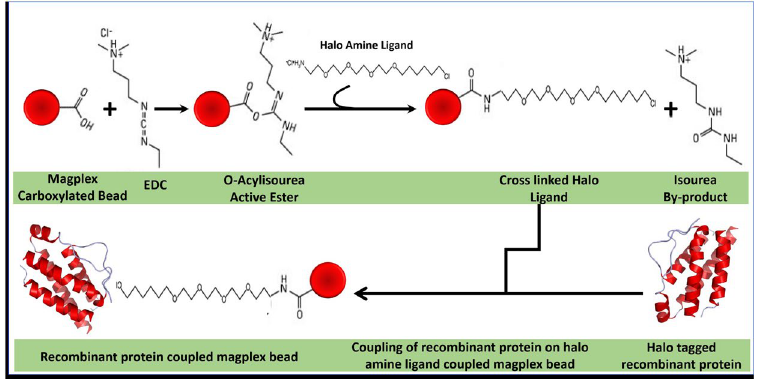
Figure 1. Strategy for coupling of halotagged recombinant TAAs on MagPlex microspheres. Halotagged recombinant proteins (HTP) were immobilized on MagPlex microspheres (BioRad, USA) by first conjugating HaloTag Amine (O4) ligand to the microspheres, using amine coupling strategy. The halo ligand immobilized magnetic micropsheres were then coupled to HTP. The coupling between HTP and HaloTag ® Amine (O4) ligand was based upon the nucleophilic attack by the chloroalkane to Asp 106 in the HTP, resulting in the formation of an ester bond between the HaloTag ligand and the recombinant protein. HTP contains a